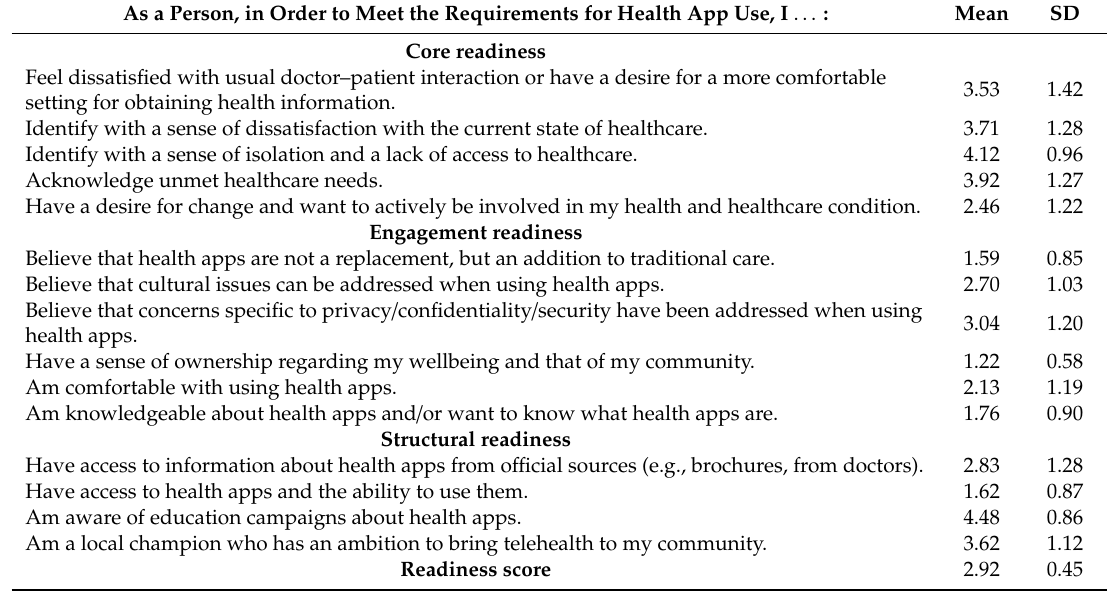
Table 2. Public readiness assessment for health app use ( n =